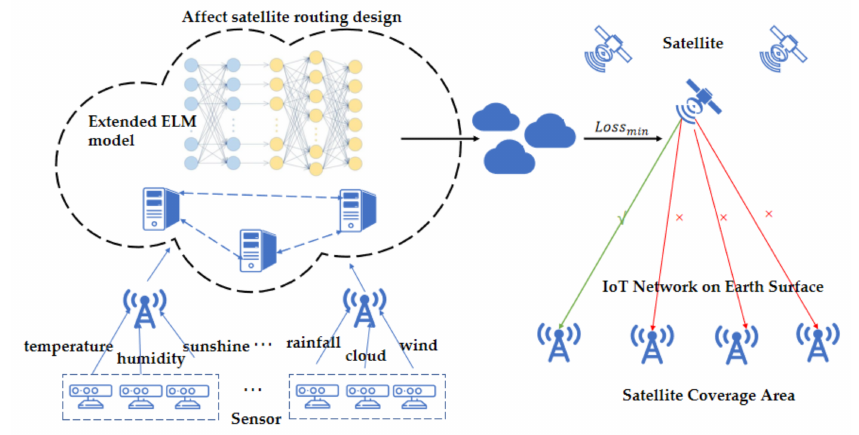
Figure 3. Schematic diagram of the system.